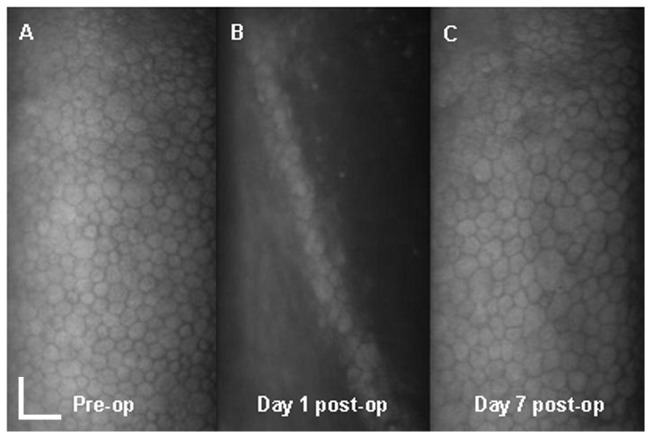
Representative specular microscopy images of endothelial cells before and after cataract surgery.(A) Prior to surgery, the endothelial cells were relatively uniform in size and shape. (B) Due to corneal edema on Day 1 after surgery, the posterior surface of cornea was uneven, and it was difficult to capture clear images for all of the endothelial cells. The entire endothelial layer was not at the same focus plane, which indicates DEC swelling. A similar finding was also evident in UHR-OCT images (refer to Figure 1C). Nevertheless, the loss of endothelial cells and the increased size of the cells were evident when compared to the pre-operative endothelium. (C) The larger cells and decrease in cell density were still evident on Day 7 after surgery. Bars = 50 μm.